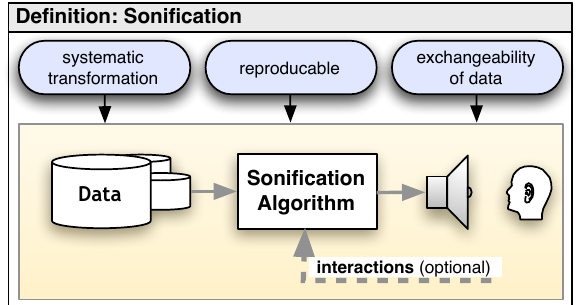
Figure 1: Illustration of the general structure and necessary conditions for sonification. The yellow box depicts